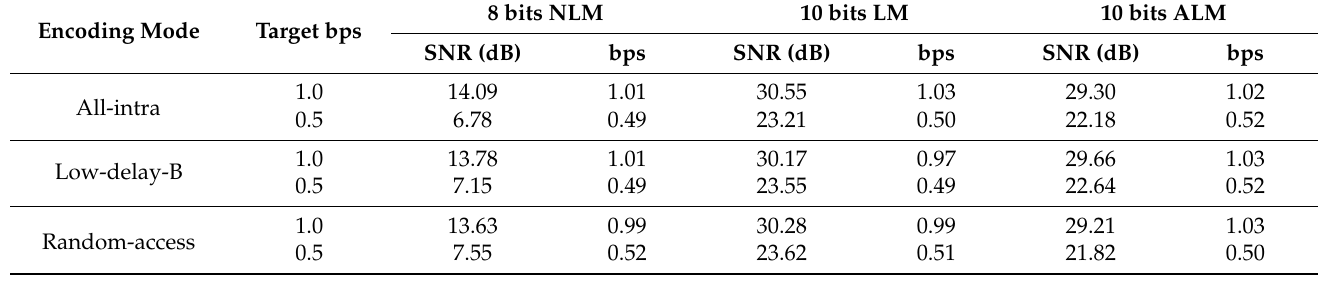
Table 4. Experimental results according to the different conversion modes.